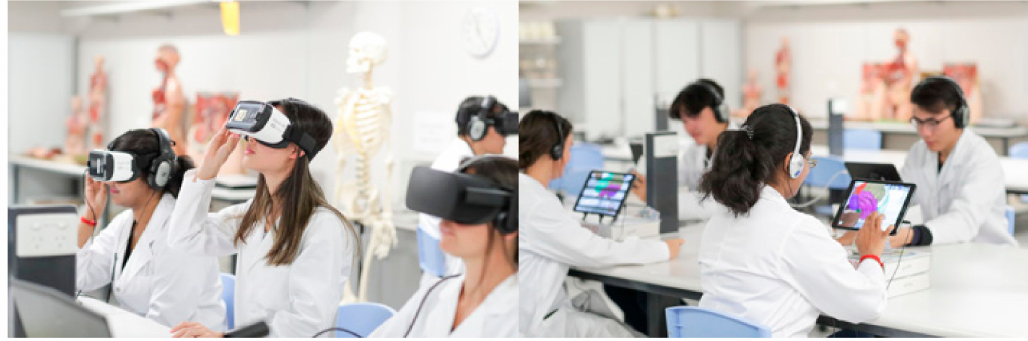
Figure 2. Health science and medicine participants utilising virtual reality via the Samsung Gear VR and Oculus Rift ( left ) and augmented reality via tablet ( right ).